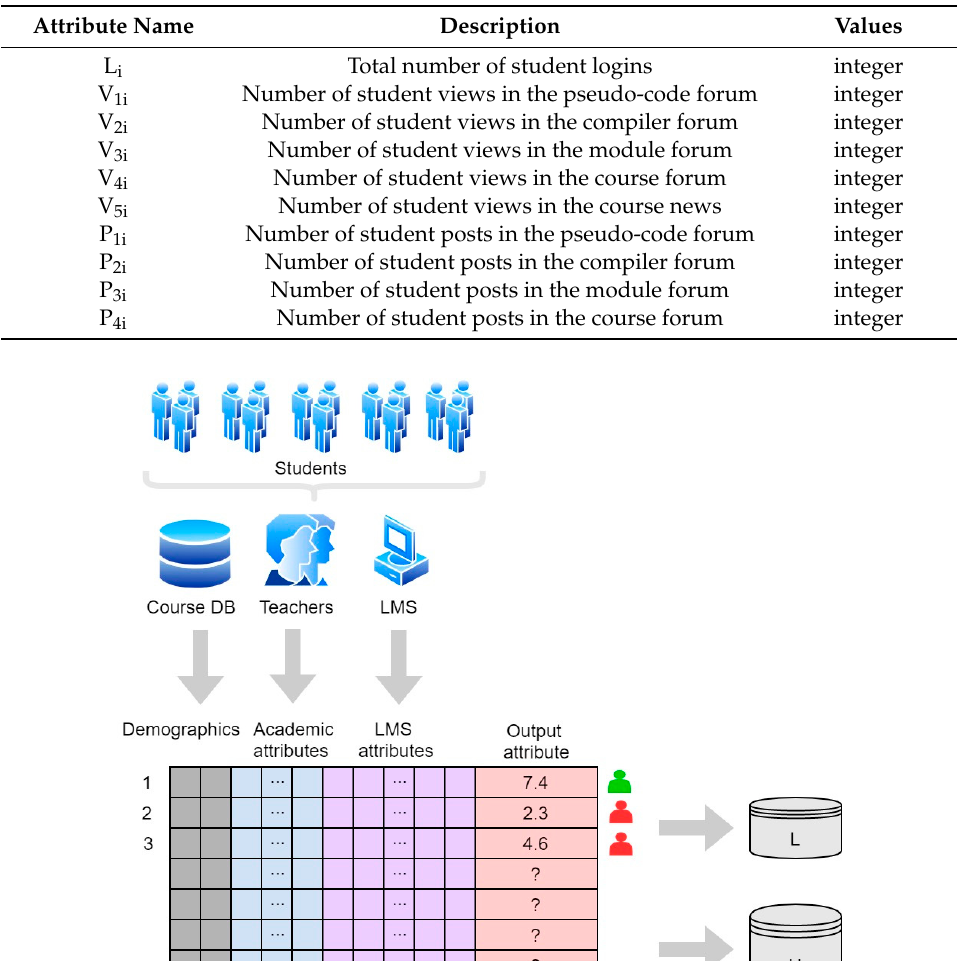
Table 3. LMS activity attributes in the i-th time-period, i ∈ { 1, 2 } .